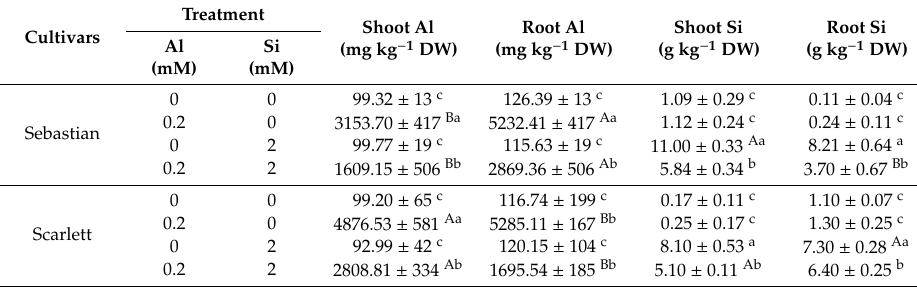
Table 2. Aluminum and silicon concentrations in roots and shoots of the two barley cultivars (Sebastian and Scarlett). Treatments were 0 or 0.2 mM Al, combined with 0 or 2 mM Si. Values represent the mean of three replicates per treatment ±